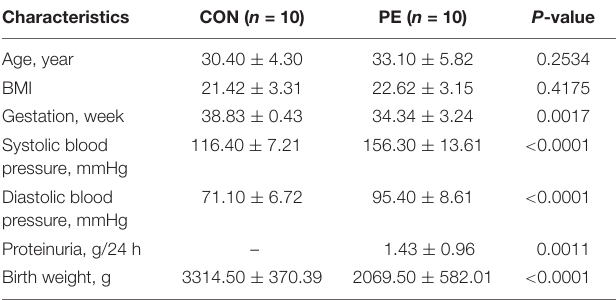
TABLE 2 | Clinical characteristics of samples for